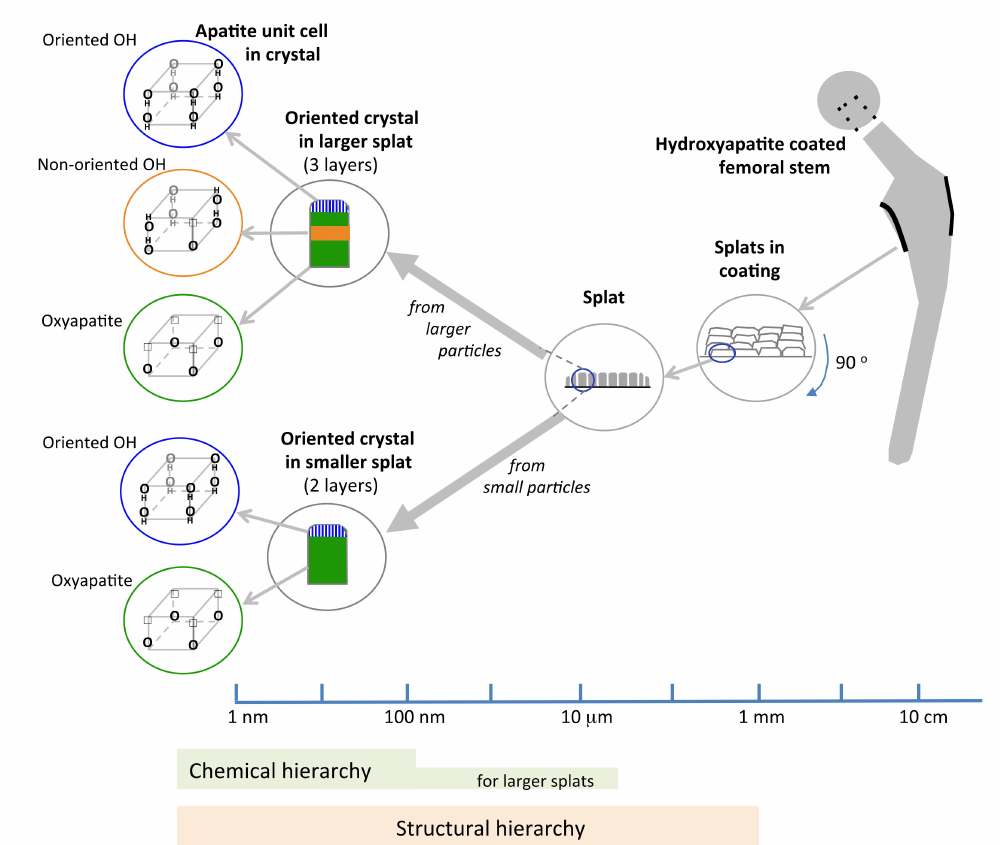
Figure 10. Proposed schema summarizing the five levels of structural hierarchy and three levels of chemical hierarchy in hydroxyapatite-coatings made from di ff erent sized